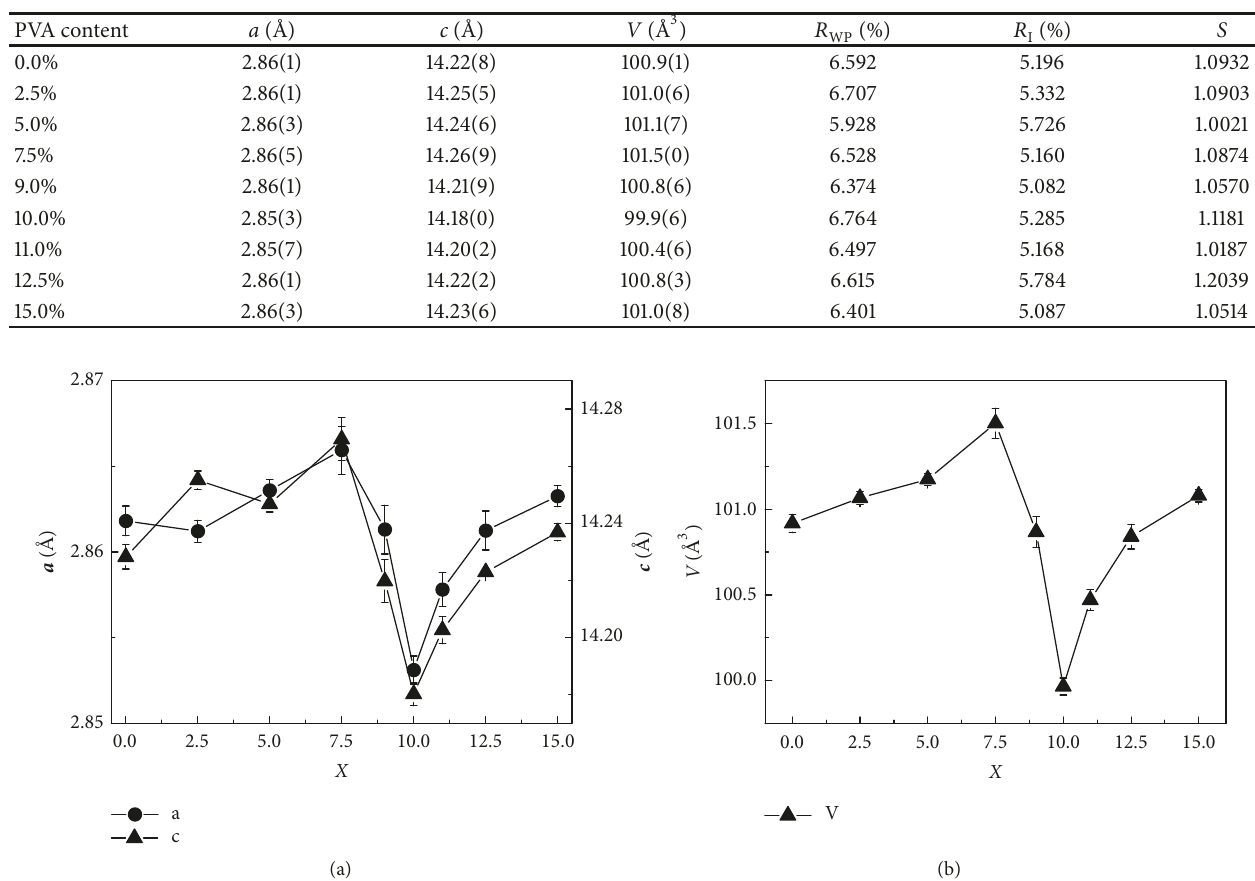
Figure 3: Variation of (a) lattice parameters a and c and (b) lattice volume V of the pristine sample and PVA-auxiliary samples, where x is the PVA